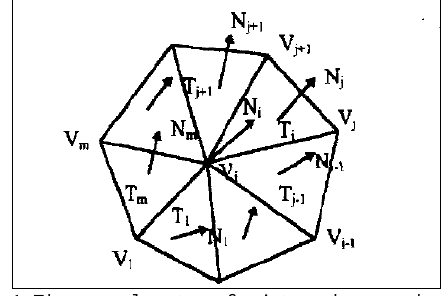
Figure1. The normal vectors of points on the curved surfaces Step 1 - Find the closest point to P , and assume it is Q , join P and Q to compose an edge of the first triangular